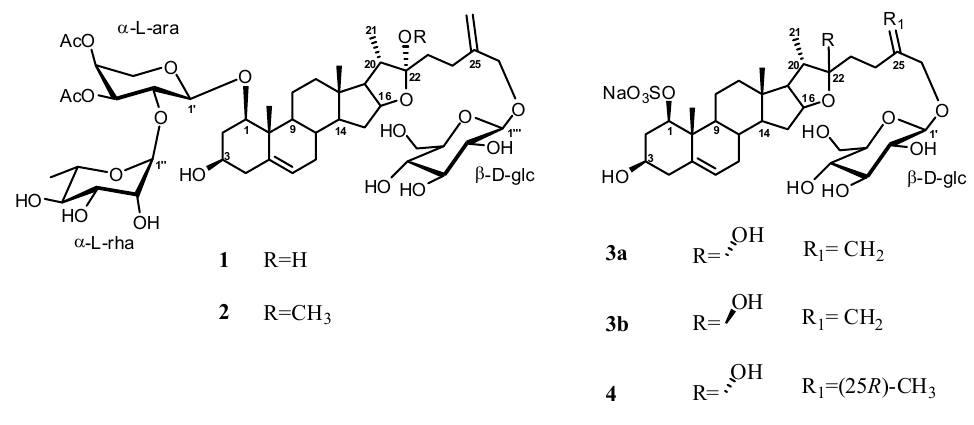
Figure 1. New compounds isolated from Ruscus aculeatus L.